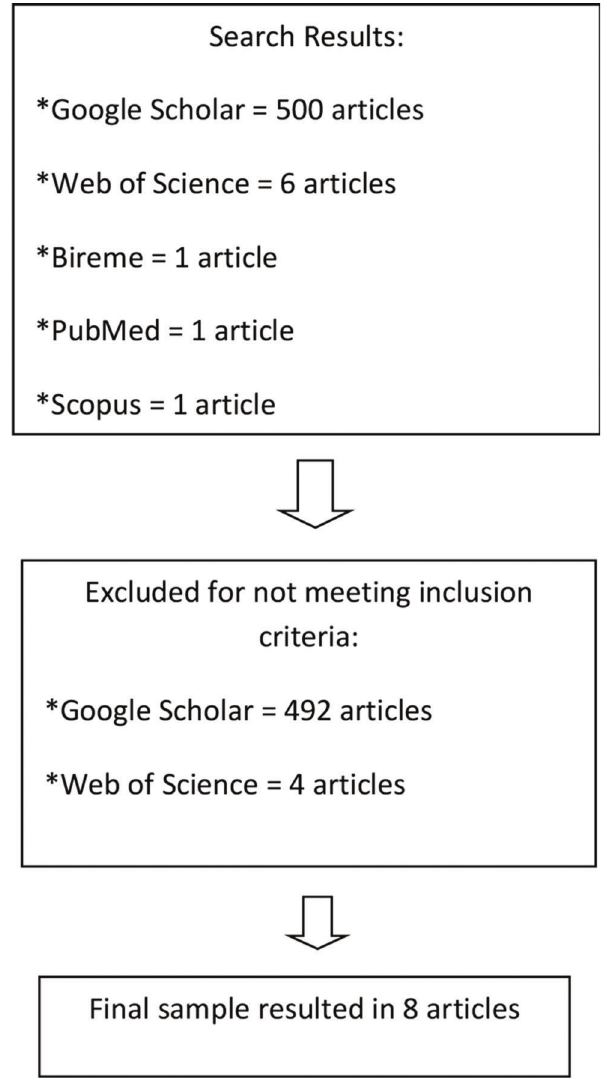
Figure 1 - Flow diagram representing the article selection